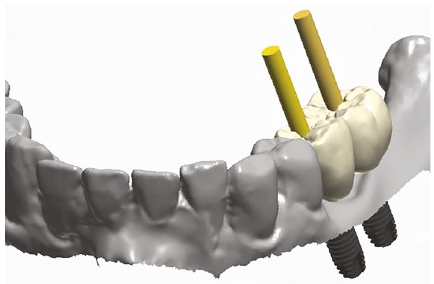
Figure 10: Digital impression posts (SIC Scan Adapter for CAD/ CAM abutments and milling blanks) with buccal alignment of the point for the immediate postoperative scan.